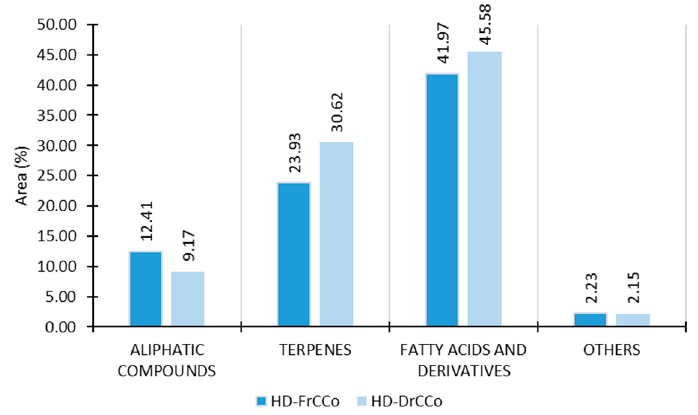
Figure 4. The VOCs of C. corniculata obtained by HD, analysed by GC-MS, and sorted by structural groups. HD-FrCC—hydrodistillate of fresh C. corniculata ; HD-DrCC—hydrodistillate of air-dried C. corniculata . Table 2. The VOCs from C. corniculata isolated by HD and analysed by GC–MS: (V—hydrodistillate of fresh C. corniculata , VI—hydrodistillate of air-dried C. corniculata ).